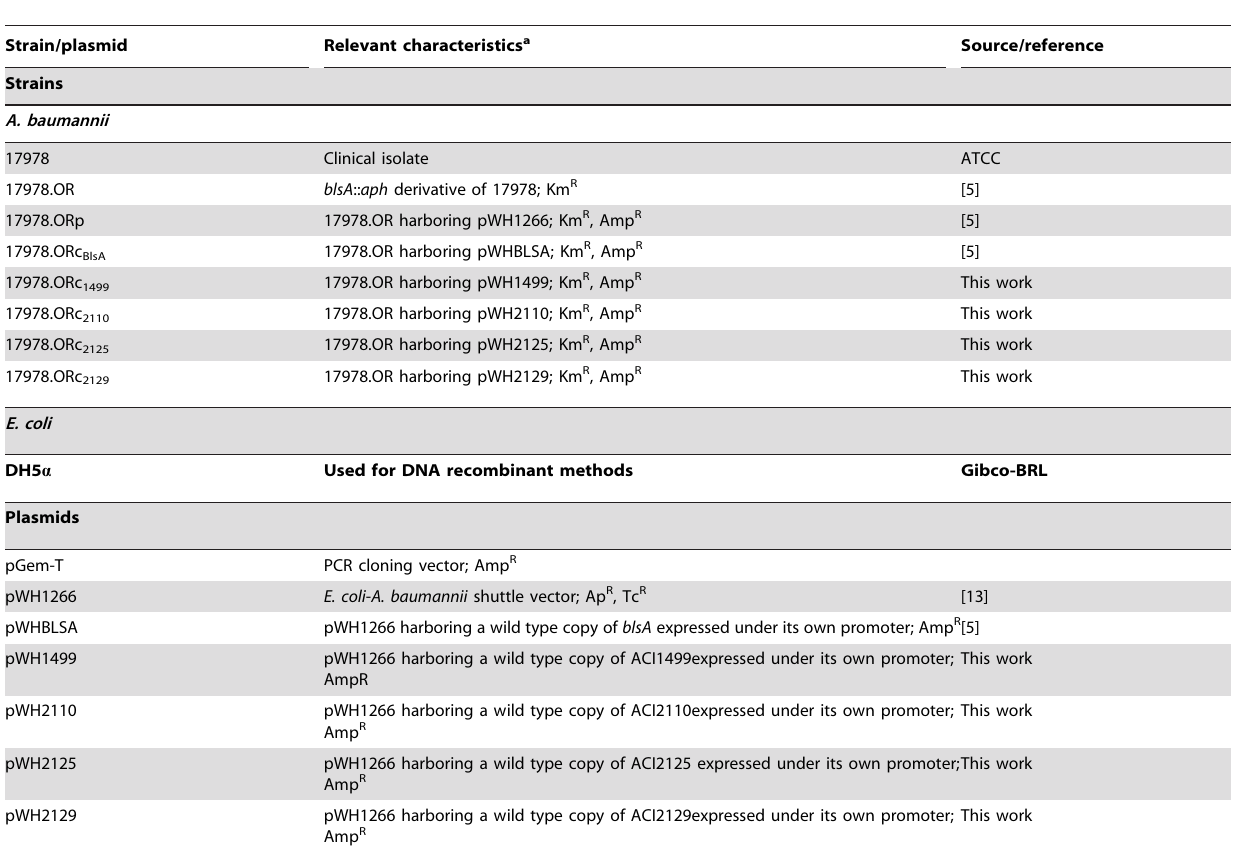
Table 1. Plasmids and strains ( A. baumannii and E. coli ) used in this study.